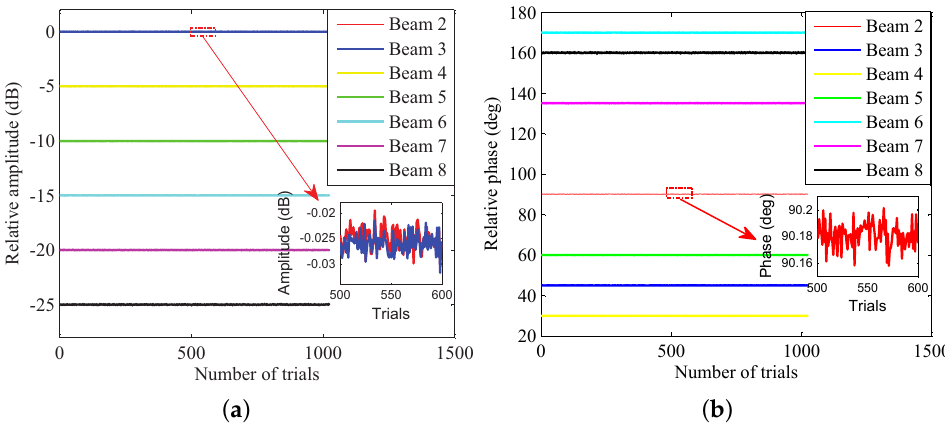
Figure 11. Experimental results. ( a ) Relative amplitude. ( b ) Relative